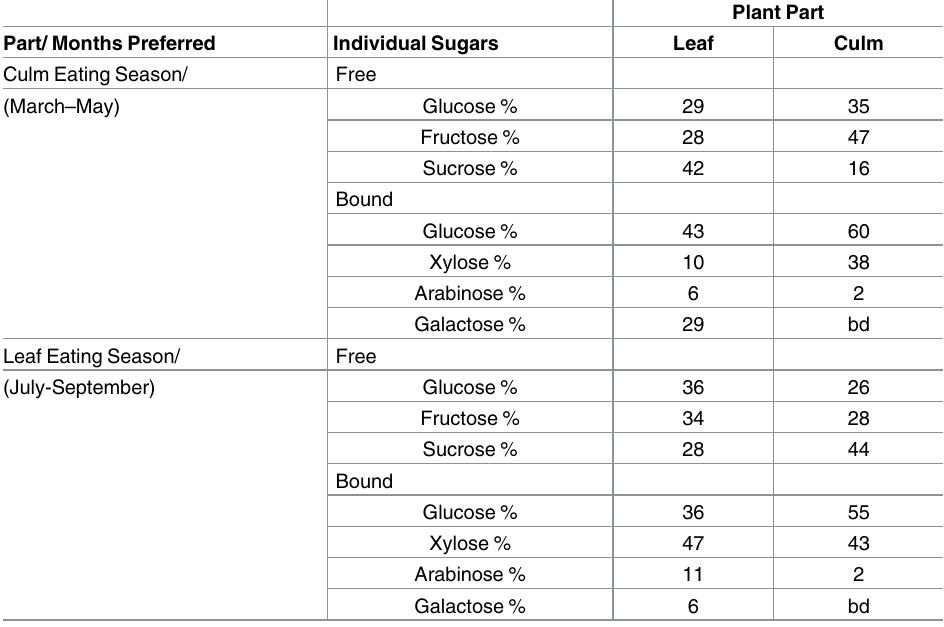
Table 2. Percentage of free and bound sugars in leaf and culm of P . aureosulcata .